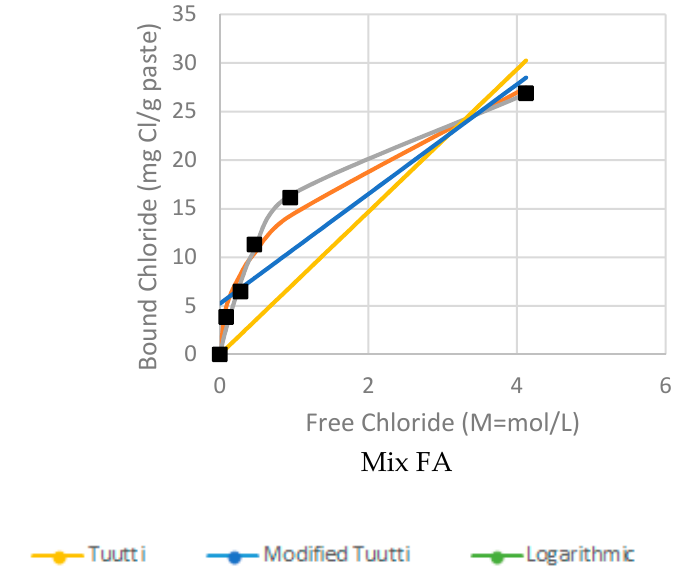
Figure 4. Graphical representation of the binding models against the experimental data. Table 3. Summary of the regression results for the binding models and the mixes that were used in this study.